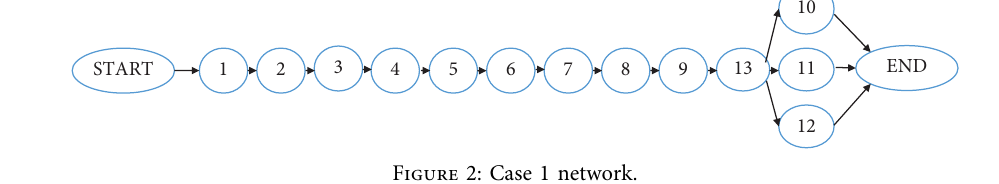
Figure 2: Case 1 network. Table 3: Specifc activities method of case 2.